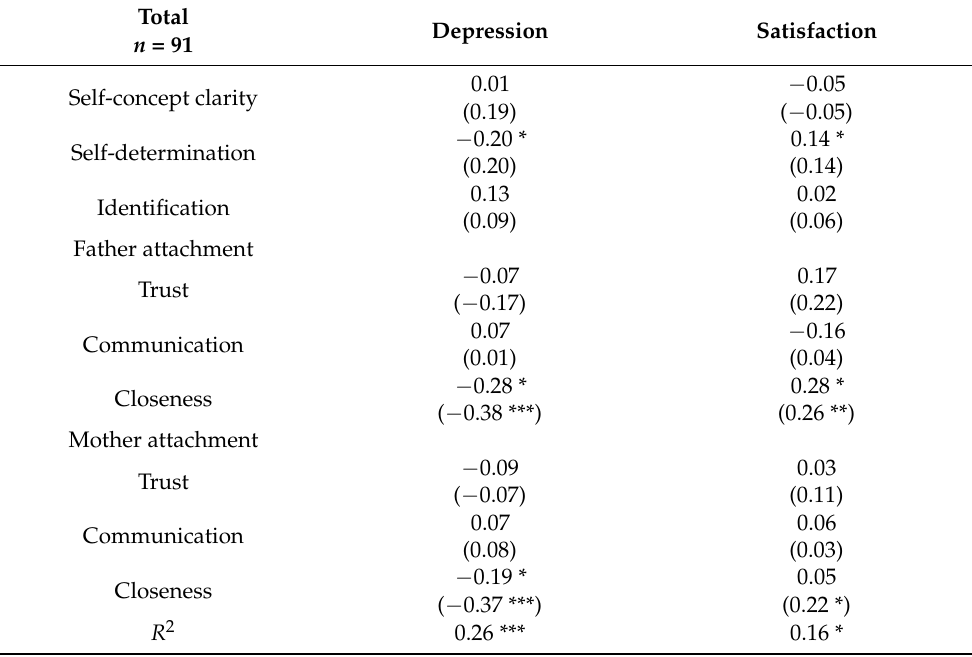
Table 3. Standardized Beta Scores and proportion of variance explained for the regression analysis on depression and life satisfaction with self-concept clarity, self-determination, dimensions of the relationship with parents and ethnic group identification as predictors.